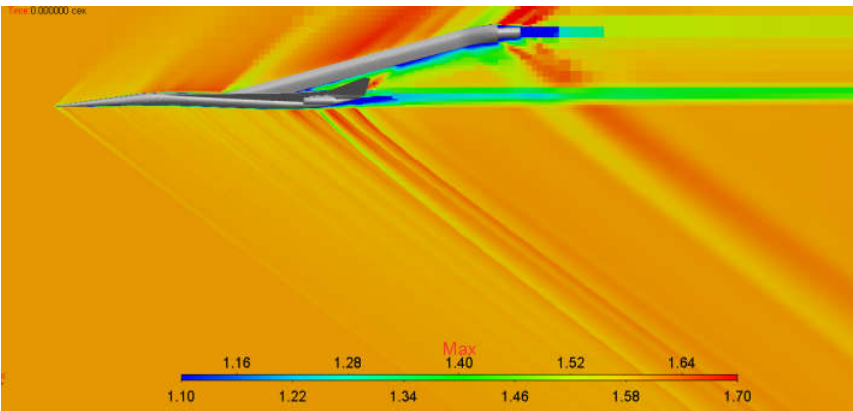
Figure 25. Mach number distribution field, the second adaptation level (LM1021).